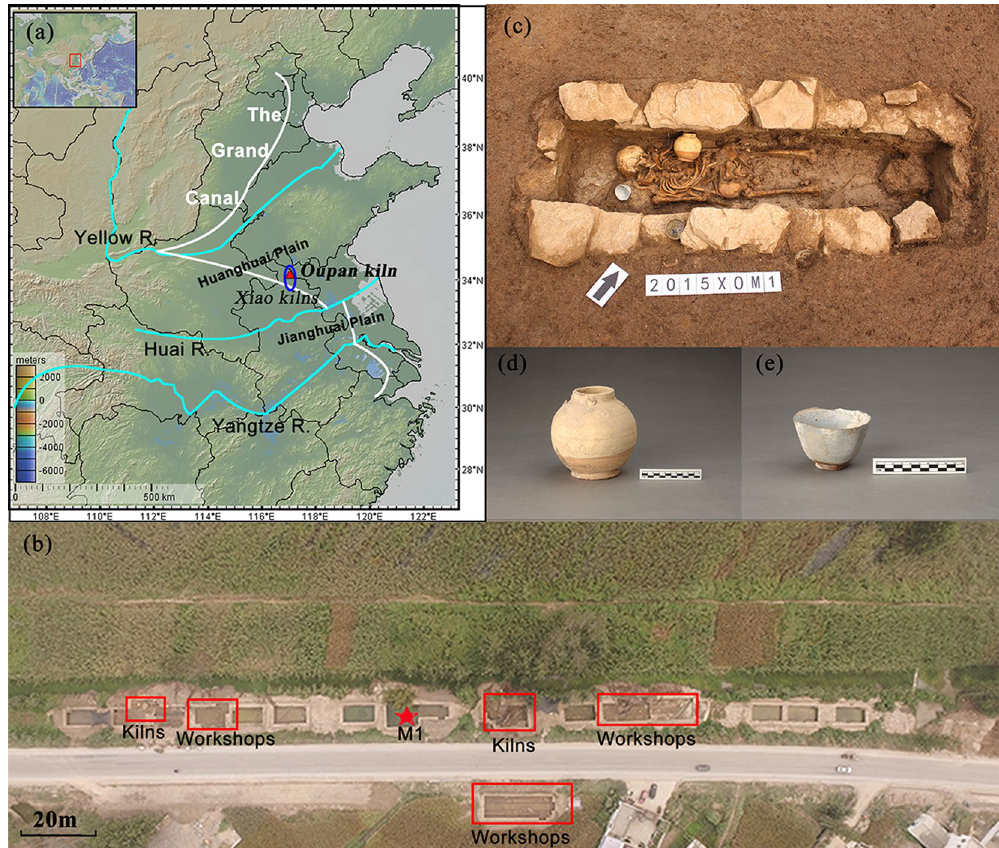
Figure 1. ( a ) Location of main sites mentioned in the text: Oupan kiln ( ▴ ), distribution of Xiao kilns ( ○ ); ( b ) Location of the tomb ( ★ ) and the kilns and workshops ( □ ); ( c ) The human skeleton buried in an extended supine position; ( d ) A yellow-glazed four loop-lugs from the tomb; ( e ) A green-glazed cup from the tomb. Maps were created with software Geo Map v 3.6.10 (http://www.geomapapp.org) 86 . Photograph reproduced with the permission of excavators (the third and fourth authors) of Oupan